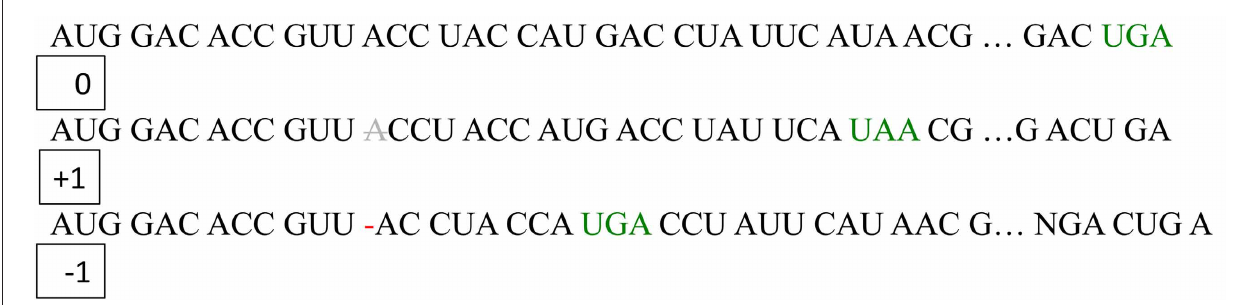
FIGURE 1 | Principle of frameshifting– + 1 vs. − 1. Frameshifting can either result in skipping of one nucleotide in the mRNA resulting in + 1 frameshifting or slipping back one nucleotide resulting in − 1 frameshifting.